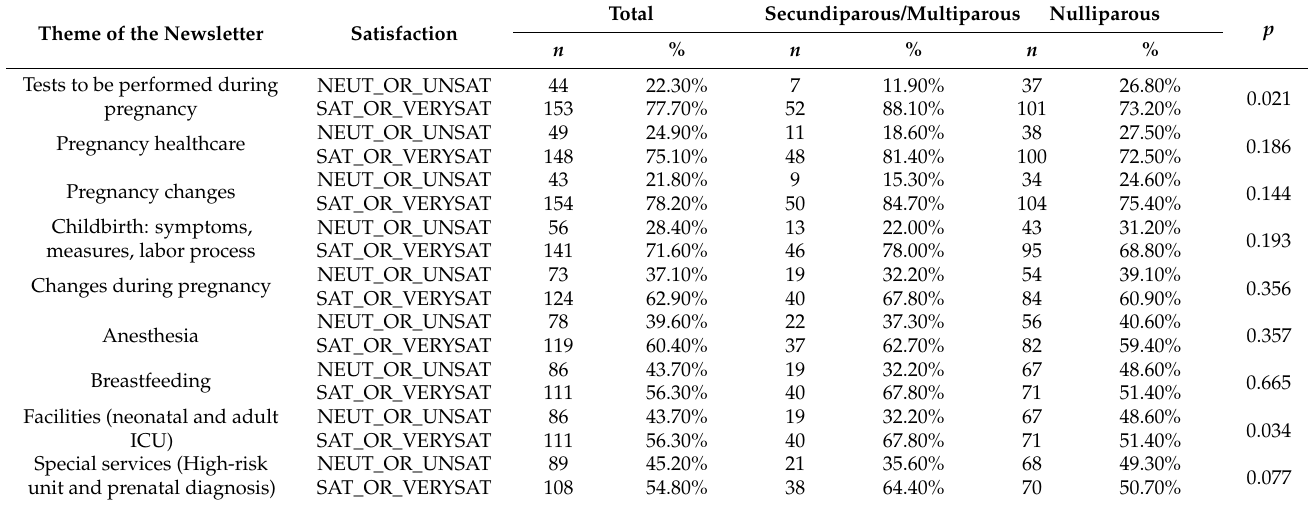
Table 2. Themes of the newsletter and satisfaction according to obstetrical